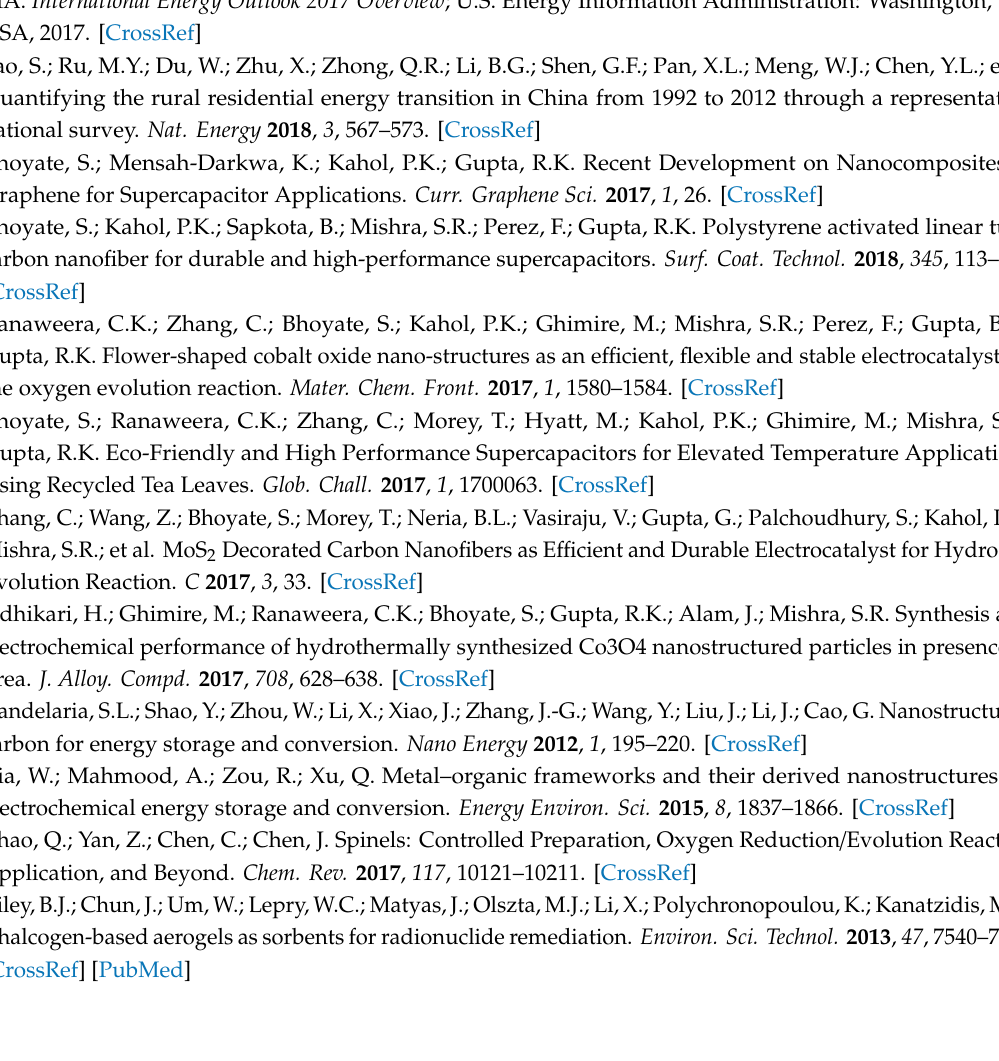
Figure S1: XPS survey spectra of (a) FeNiO and (b) sulfurized FeNiO. Figure S2: (a) Nyquist plot for all the OER catalytic electrodes at 0.5 V, (b) Nyquist plot at di ff erent stability cycles at 0.5 V, (c) Nyquist plot at di ff erent bending angles at 0.5 V, and (d) chronoamperometry. Figure S3: (a) Nyquist plot at di ff erent stability cycles at − 1.3 V, (b) Nyquist plot at di ff erent bending angles at − 1.3 V and, (c) chronoamperometry. Figure S4: LSV polarization curves for Pt / C and IrO 2 : (a) HER and (b) OER. Figure S5: Characteristics of FeNiS: (a) CV curves, (b) GCD curves and (c) cyclic stability plot for FeNiS sample using GCD measurements. Table S1. Comparison of OER catalysis with other reports. Table S2. Comparison of HER catalysis with other reports. Table S3. Comparison of overall water splitting. Table S4. Comparison of supercapacitor performance of some recently reported